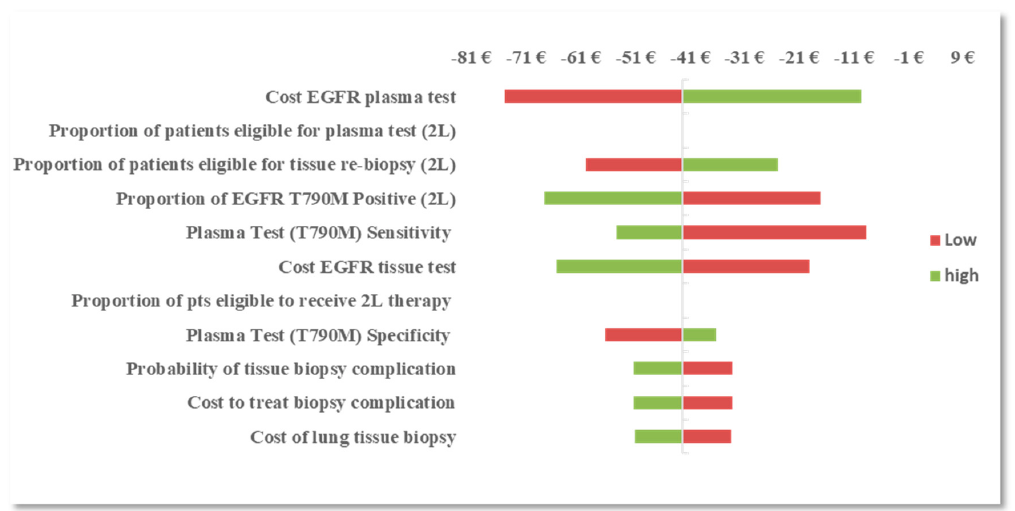
Figure 2. OWSA: difference in BI between the EGFR mutation plasma reflex testing approach and the tissue testing approach in the second-line (2L) setting.